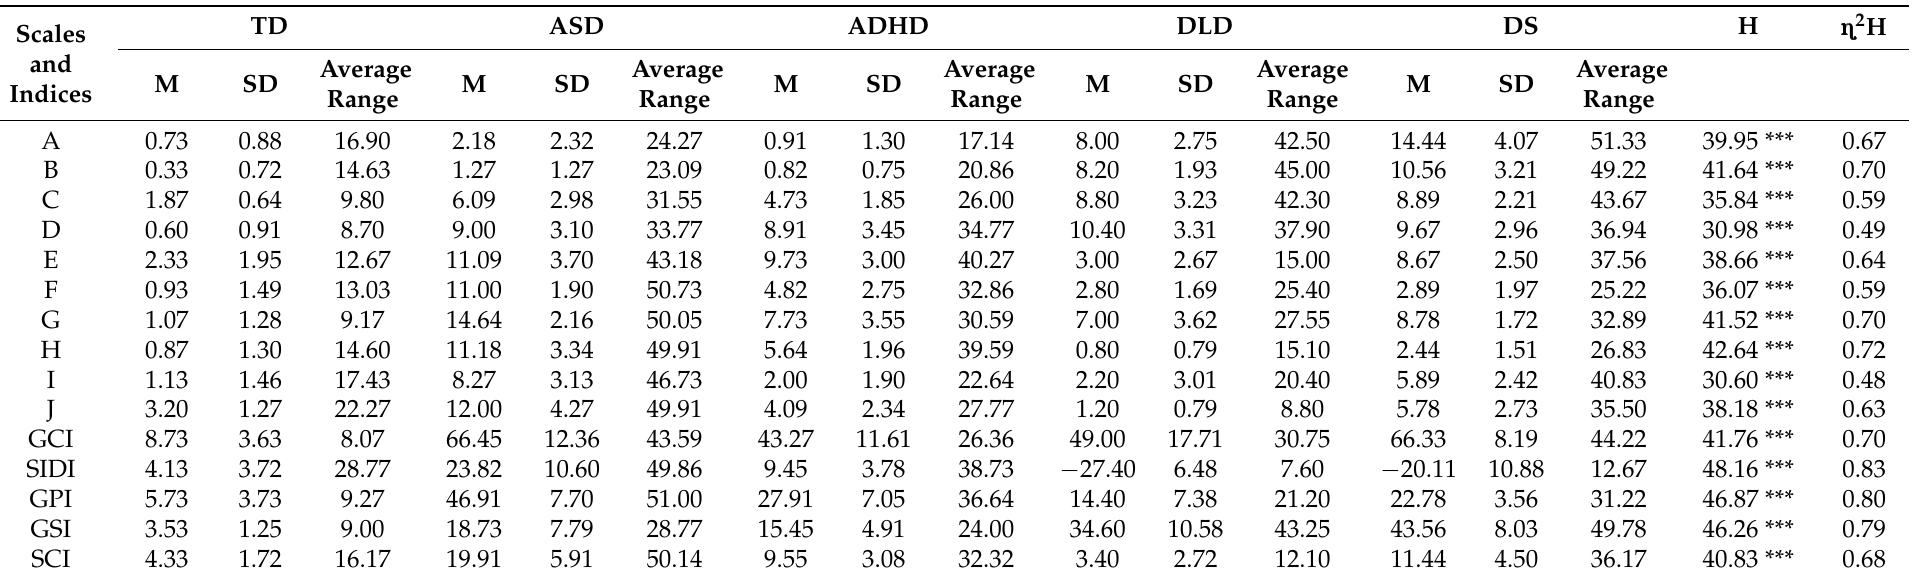
Table 5. Means (M), standard deviations (SD) and average ranges of the five groups at school age and analysis of the differences through the Kruskal–Wallis test. Scales